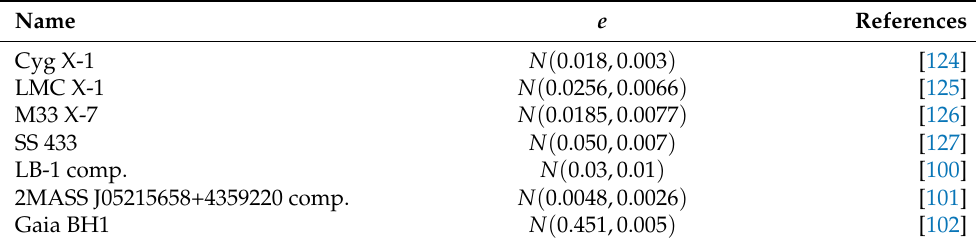
Table 2. Masses and Binary Parameters, where applicable, for six Black Hole